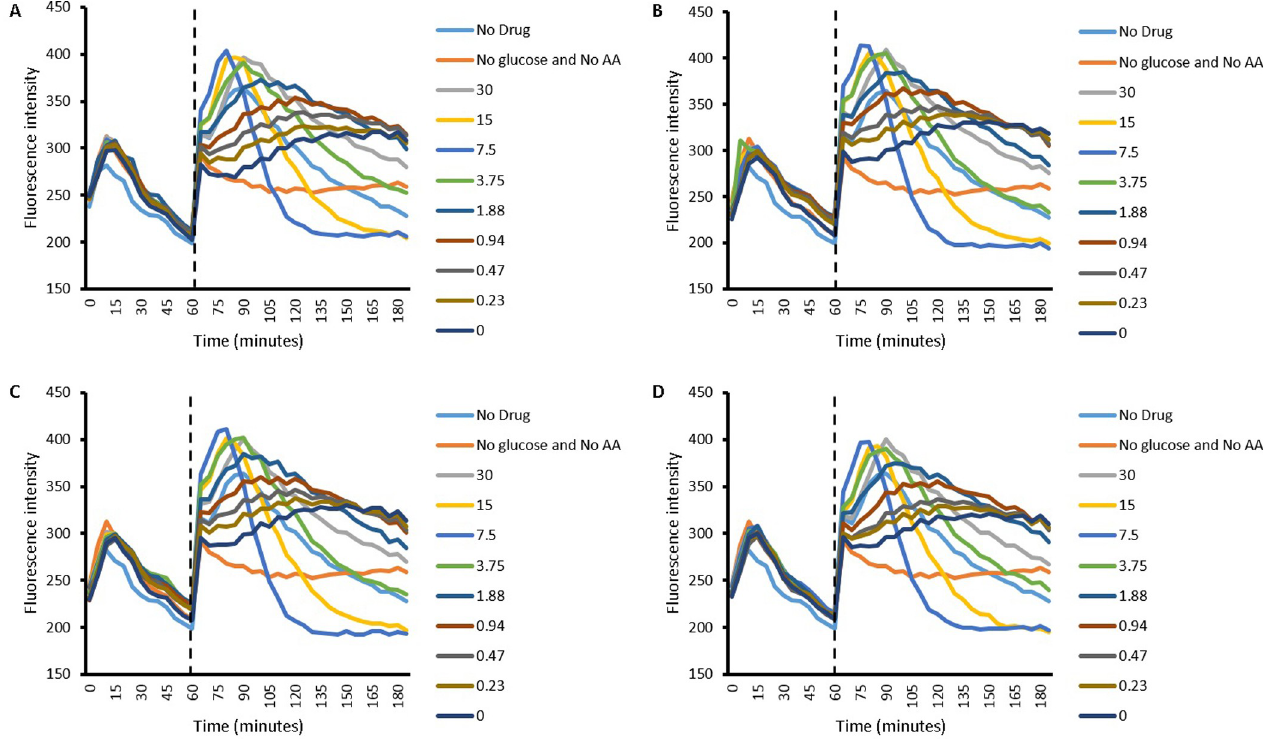
Fig 1. Efflux of EtBr by S . aureus in the presence of different concentrations of L-Asp (30 mM to 0.23 mM). A) 8.49 μ M Cip B) 4.24 μ M Cip C) 2.12 μ M Cip D) 1.06 μ M Cip. In the legend, numbers 0 to 30 represent amino acid concentrations in combination with respective Cip concentration. Firstly the dashed line represents end of first part of experiment where Cip and EtBr was allowed to accumulate within energy deprived cells and secondly the start of accumulation in the presence of the amino acid, with or without energy; n = 4.